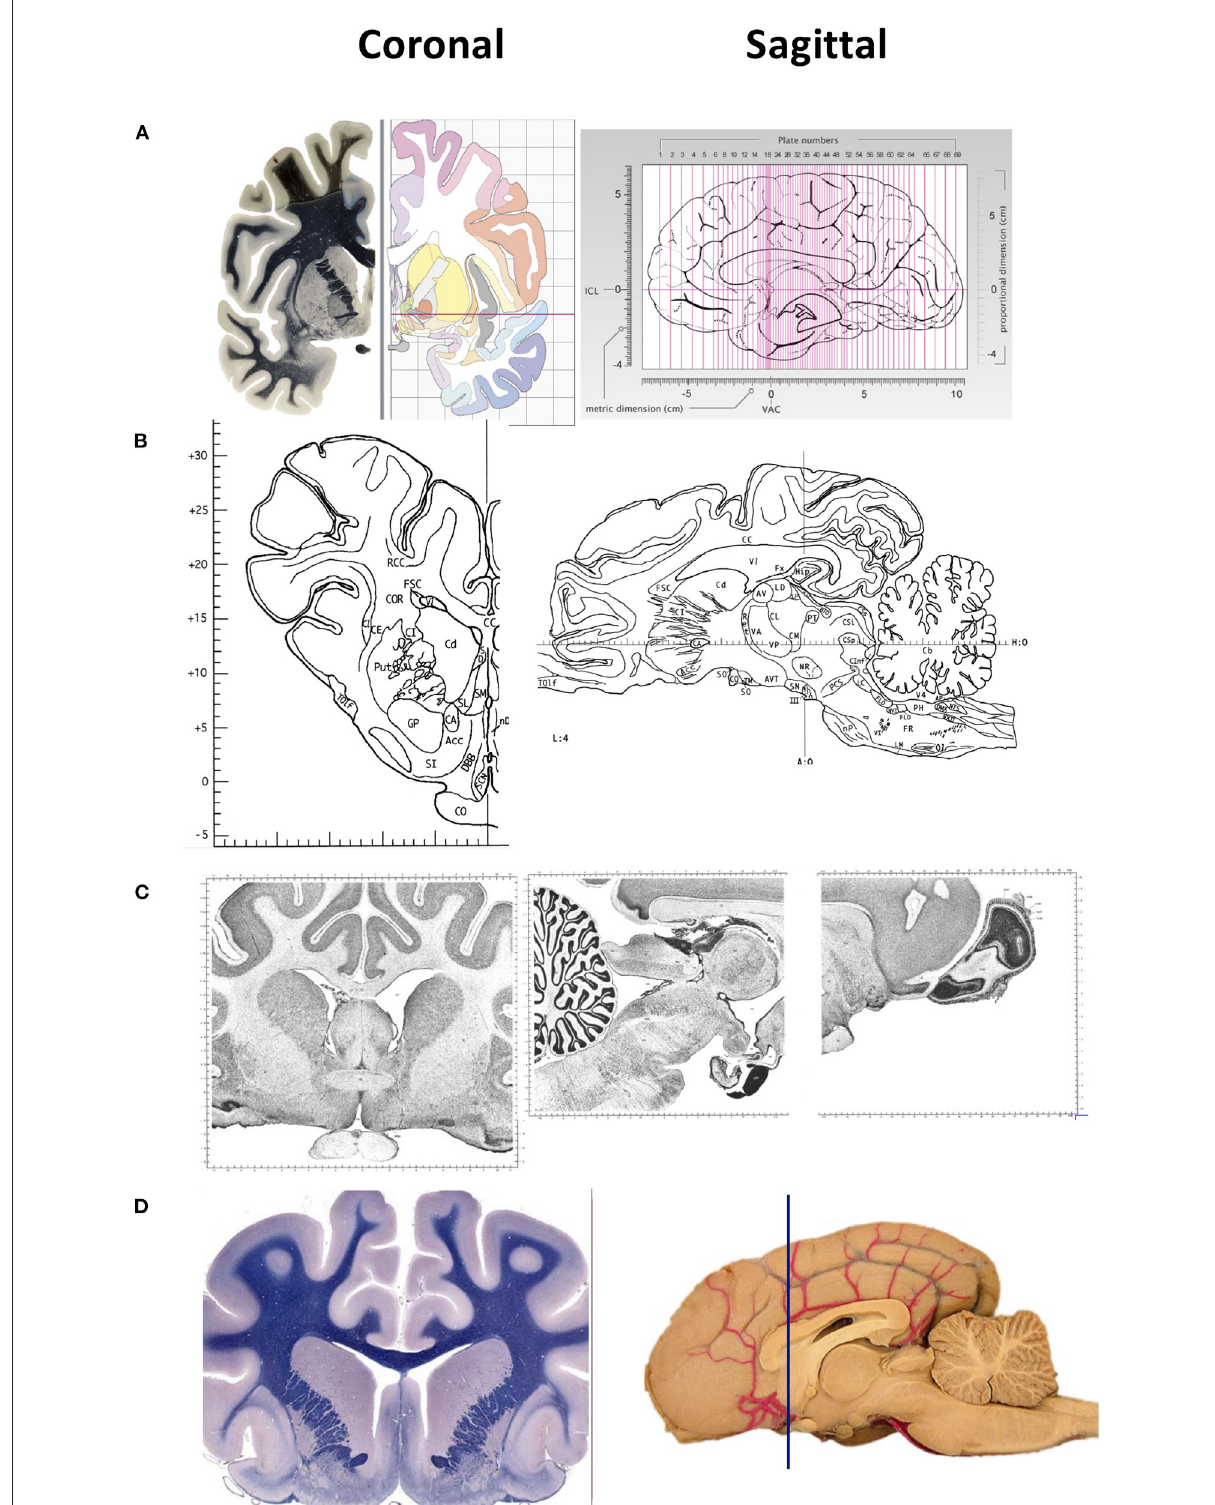
FIGURE1 Representative images of two-dimensional sections of the brain, coronal (right) and sagittal (left) sectons of brains of various species. (A) Human brain. Coronal sections show the fiber tracts in the left panel and schematic diagrams in the right panel. The sagittal section shows the plane